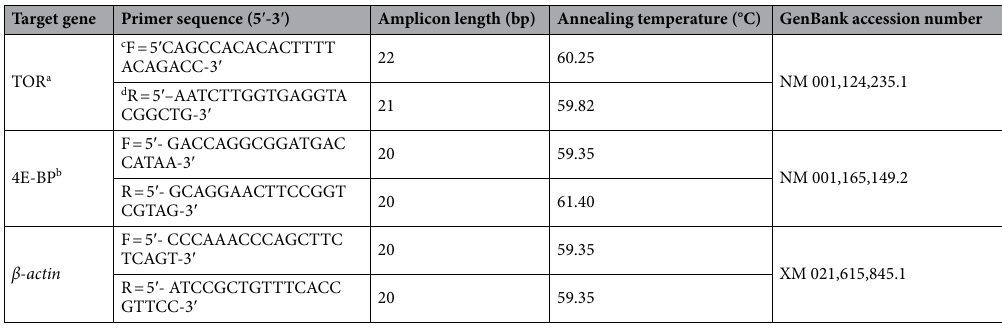
Table 6. Real-time PCR primer sequences of rainbow trout. a TOR = Target of rapamycin. b 4E-BP = ELF4E- binding protein. c F = Forward. d R =